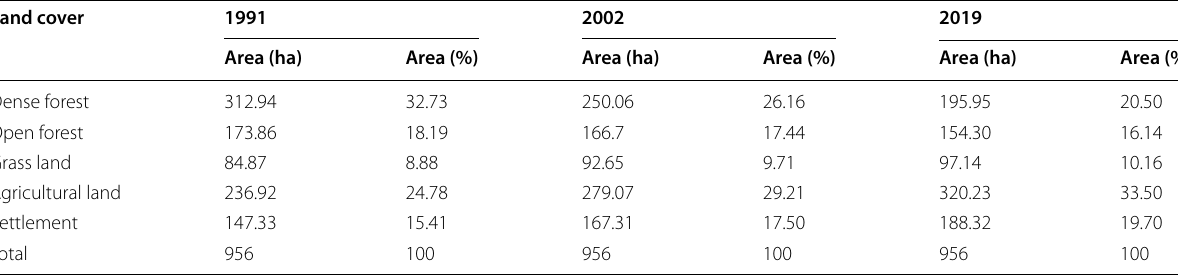
Table 4 Land use land cover areas in 1991, 2002 and 2019 Land cover 1991